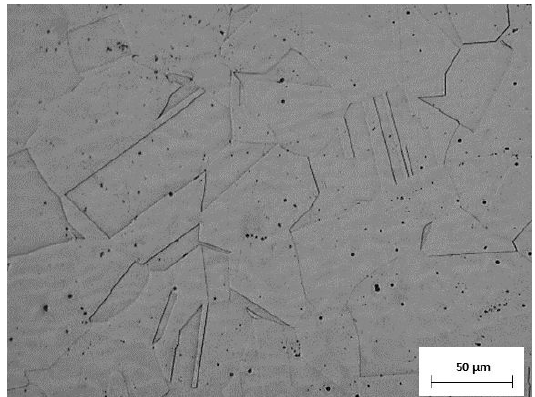
Figure 6. CPTs results of UNS S32750 samples. Crevice corrosion occurrence represented in dotted lines.